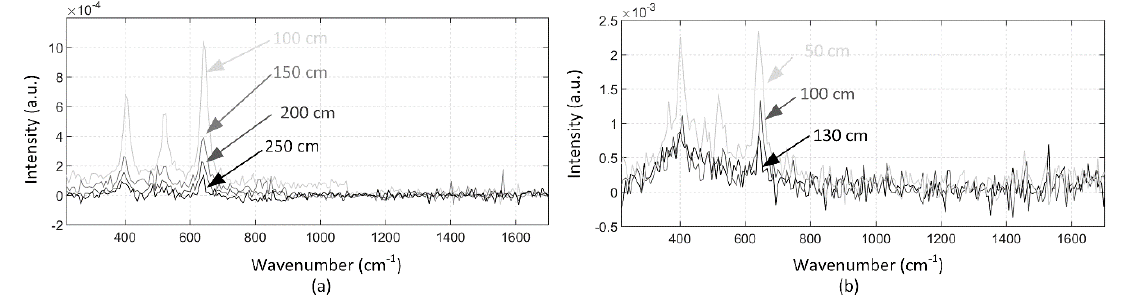
Figure 7. Raman spectra of TiO 2 measured ( a ) by gating the bins of the time-to-digital converter (TDC) to collect photons from targets at 100 cm, 150 cm, 200 cm and 250 cm, and ( b ) by collecting photons within the 10 ns collection window from targets at 50 cm, 100 cm and 130 cm with the normal laboratory lights on.